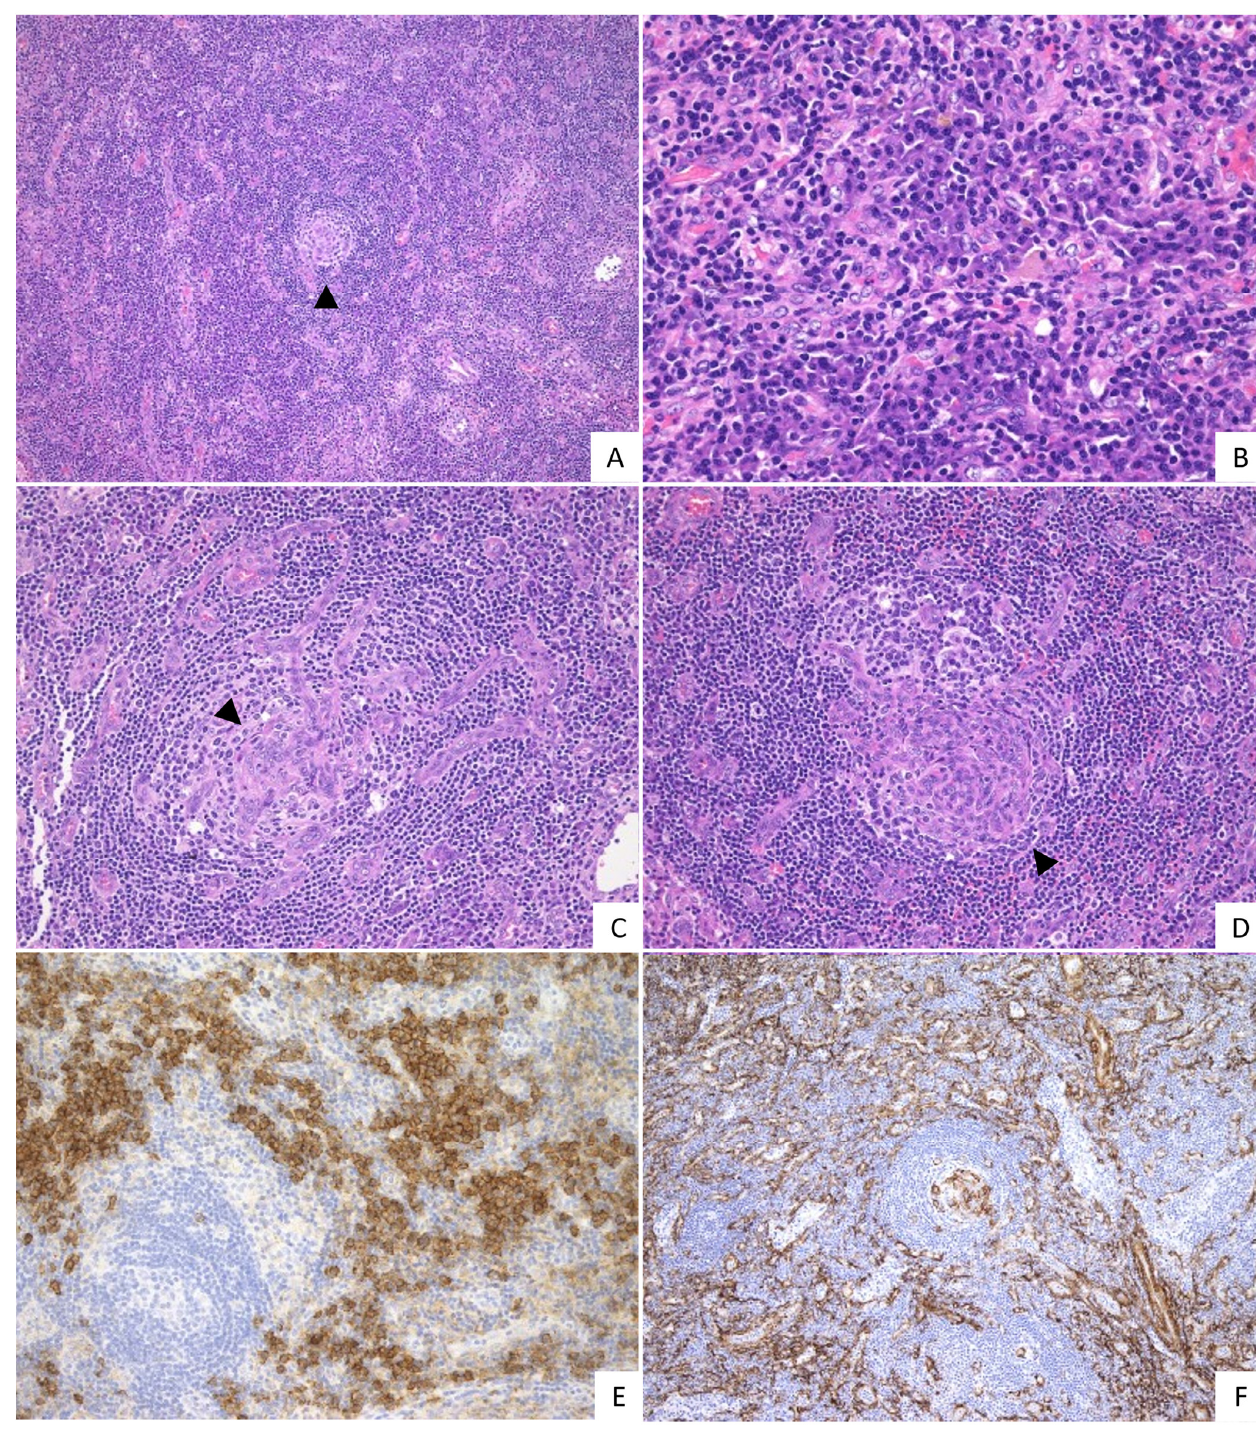
Figure 2. Histopathological features of the non-IPL group. ( A ) Extended interfollicular areas and severe vascularization are observed. Germinal center (GC) is atrophic (arrowhead) (H&E, 10×). ( B ) Mature plasma cells are observed within prominent vascularization (H&E, 40×). ( C , D ) Marked hypervascularization penetrating the GC is observed. The blood vessels show a branching pattern (( C ), arrowhead) and whirl-like pattern (( D ), arrowhead) (H&E, 20×). ( E ) Numerous plasma cells are observed in the interfollicular areas (CD138, 20×). ( F ) Vascular in the GC and interfollicular areas were α-SMA-positive (α-SMA, 10×). This case was scored vascularity grade 3, plasmacytosis grade 2, regressed GC grade 3 and hyperplastic GC grade 0.